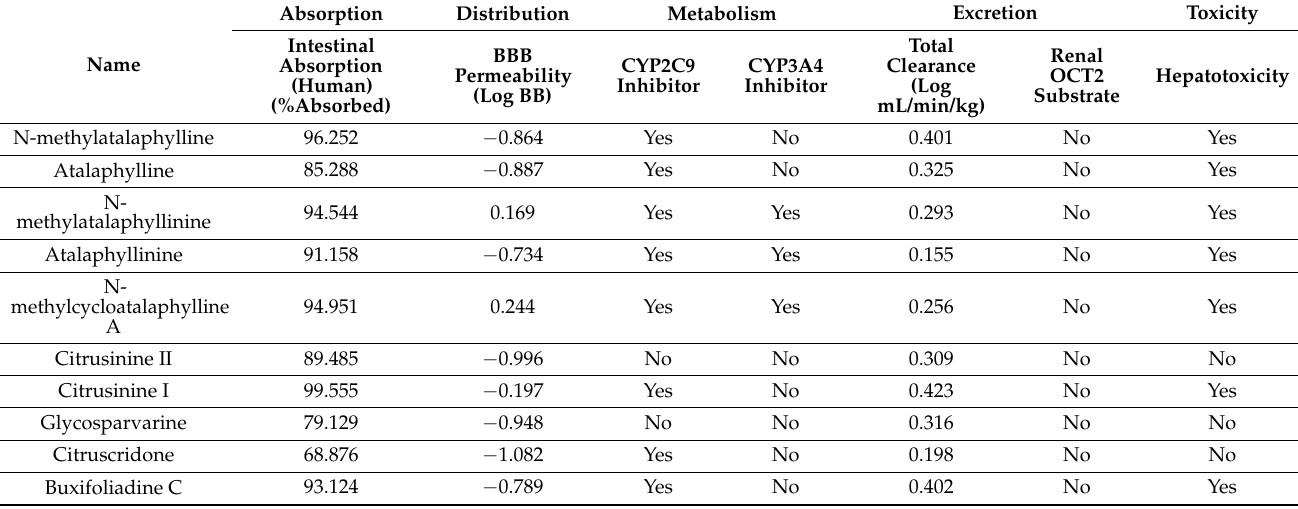
Table 3. ADMET parameters of acridones predicted by in silico analysis (pKCSM